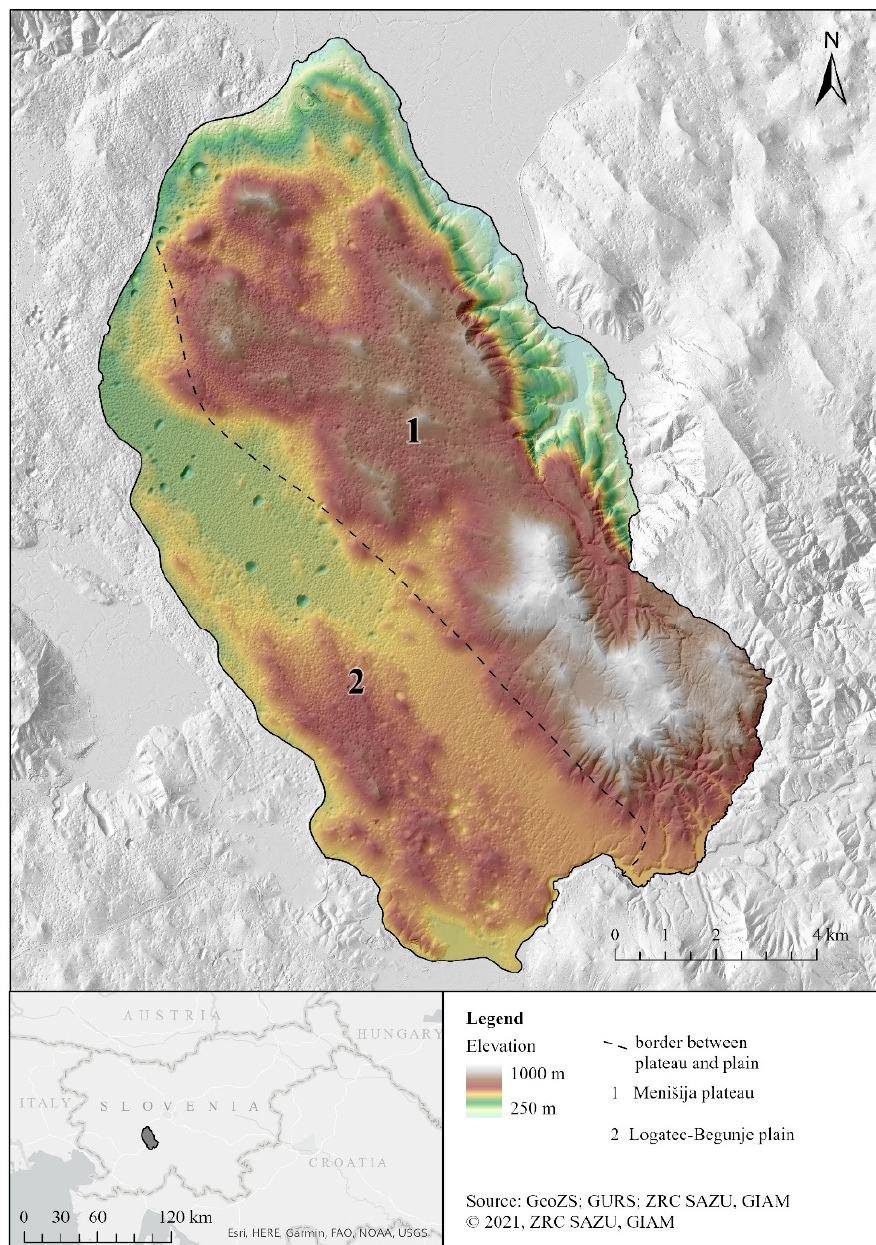
Figure 1. Map of the study area and location of the two regions considered (1—Menišija plateau; 2—Logatec-Begunje plain/Ravnik).